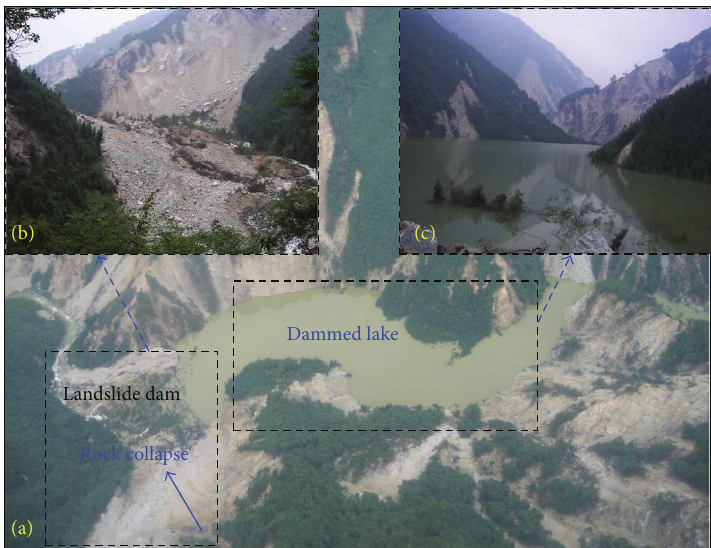
Figure 1: The Jiadanwan landslide dammed lake, (a) aerial photo, and (b) site photo of the landslide dam; (c) site photo of the dammed lake.